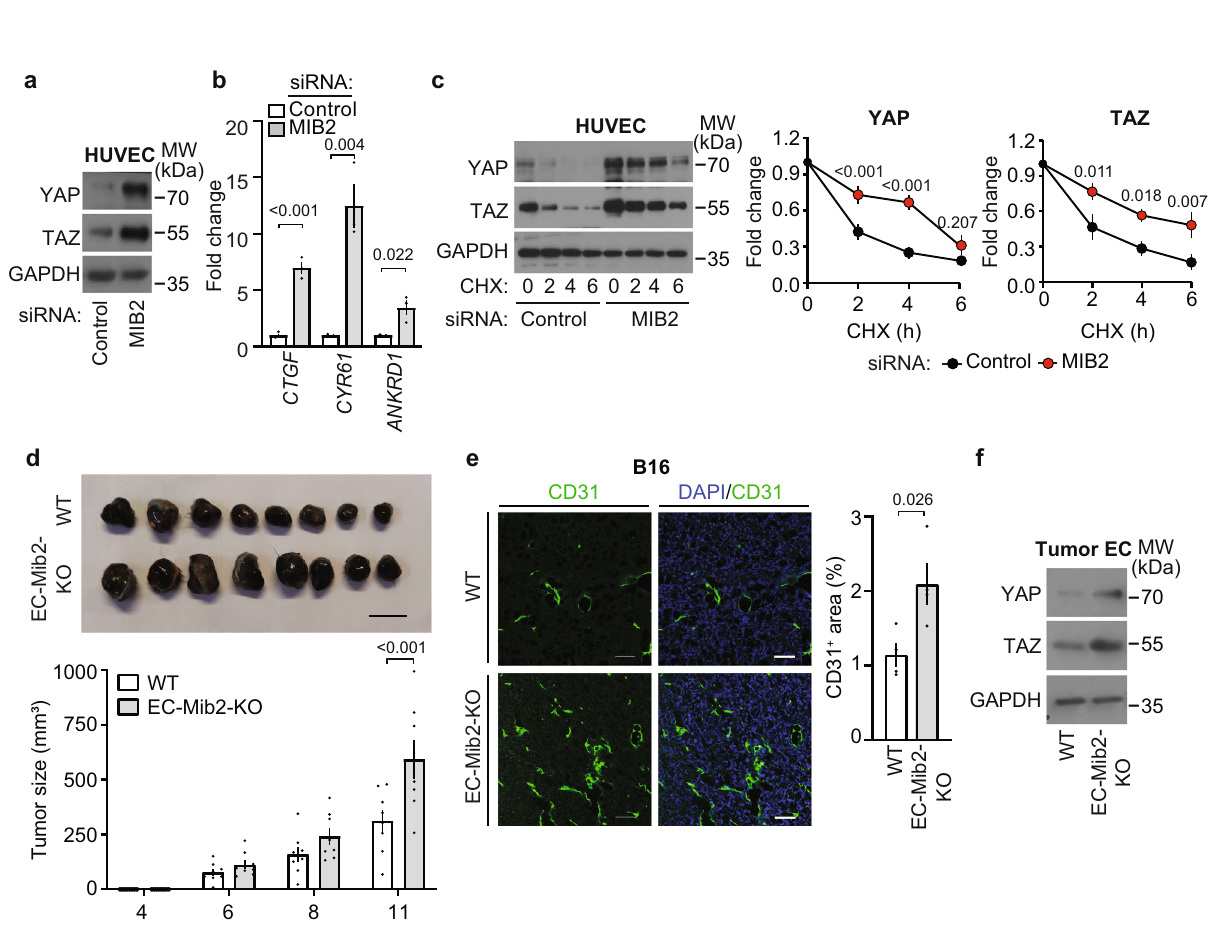
Fig. 7 | Role of MIB2 in endothelial cells in vivo and in vitro. a – c HUVECs were transfected with control siRNA or siRNA directed against MIB2 as indicated. 24h later,YAP/TAZproteinlevelswereanalyzedbyimmunoblotting( a ),YAP/TAZtarget genes were analyzed by qRT-PCR ( b ) and YAP and TAZ protein degradation was determined after incubation of cells with 50 µ g/ml cycloheximide (CHX) for the indicated time periods and subsequent immunoblotting using anti-YAP/TAZ anti- bodies ( c )( n =3independentexperimentsin b and c ). d Tumor development after subcutaneous injection of B16 melanoma cells into control and EC-Mib2-KO mice